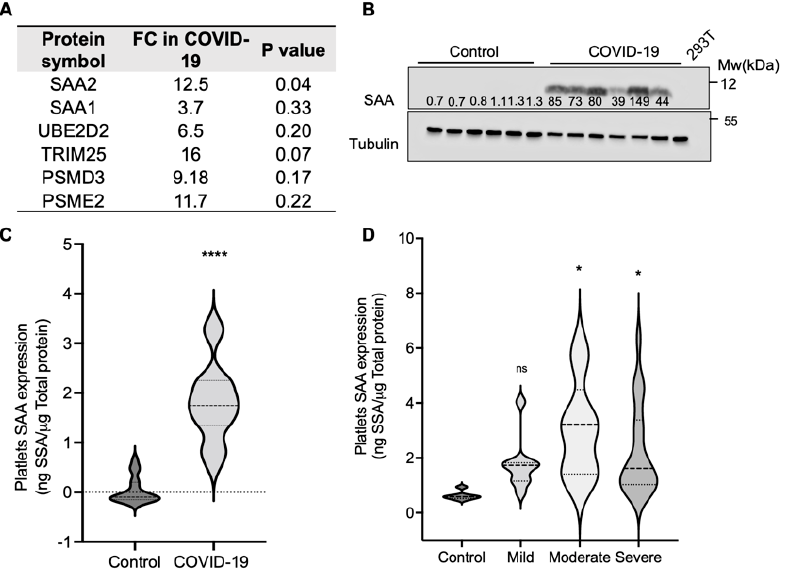
Figure 1. SAA is bound to platelets from COVID-19 patients. ( A ) Mass spectrometry was used to identify and quantify proteins overexpressed in purified COVID-19 platelets compared to controls. Shown are proteins whose levels were consistently elevated in two independent experiments. Values indicate the average fold-change (FC) in the relative label-free quantification intensity between the COVID-19 and the control samples ( n = 4 in each group). Unpaired Student’s t -test was used to determine the significance. ( B ) Platelet lysates from control or COVID-19 donors were separated using SDS-PAGE. SAA was detected using a specific antibody. Tubulin was used as a loading control. Results are representative of six controls and six COVID-19 patients. Numbers represent fold intensity of control densitometric values normalized to tubulin. ( C ) SAA levels in platelet lysates from controls ( n = 17) or COVID-19 patients ( n = 15) were determined using ELISA. The dashed line in the violin plot is the median. The dotted lines show the interquartile range. Unpaired t -test, **** p < 0.001. ( D ) Platelet lysates from control or COVID-19 donors separated according to disease severity were analyzed using SDS-PAGE ( n = 6 controls, 9 mild, 5 moderate, and 20 severe disease patients). SAA was detected using a specific antibody. The results were normalized to tubulin and to the amount of total protein. Ordinary one-way ANOVA, Dunnett’s multiple comparisons compared to control, ns = non-significant, * p < 0.05.